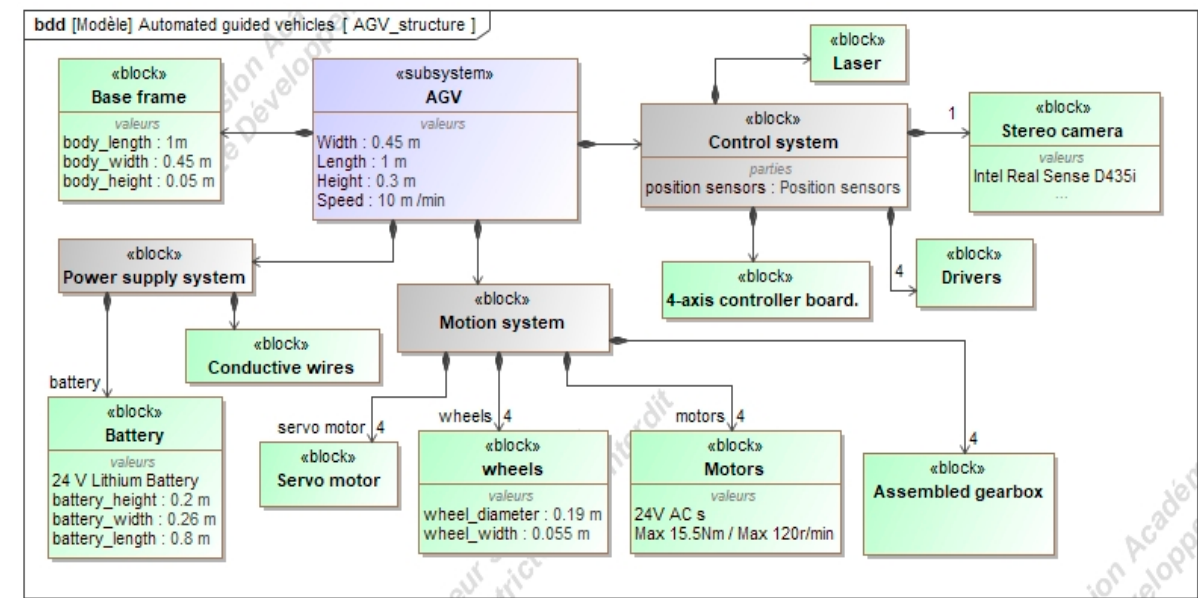
Figure 13. Architecture of the AGV system in SysML.